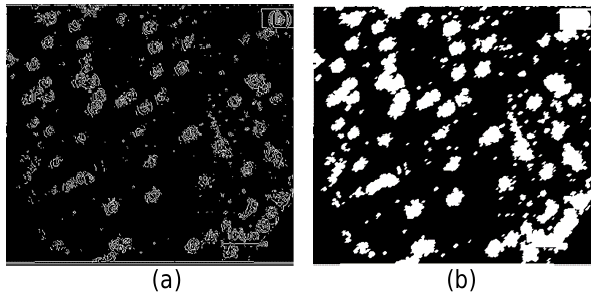
Figure 7. (a) Illustrates the effect of